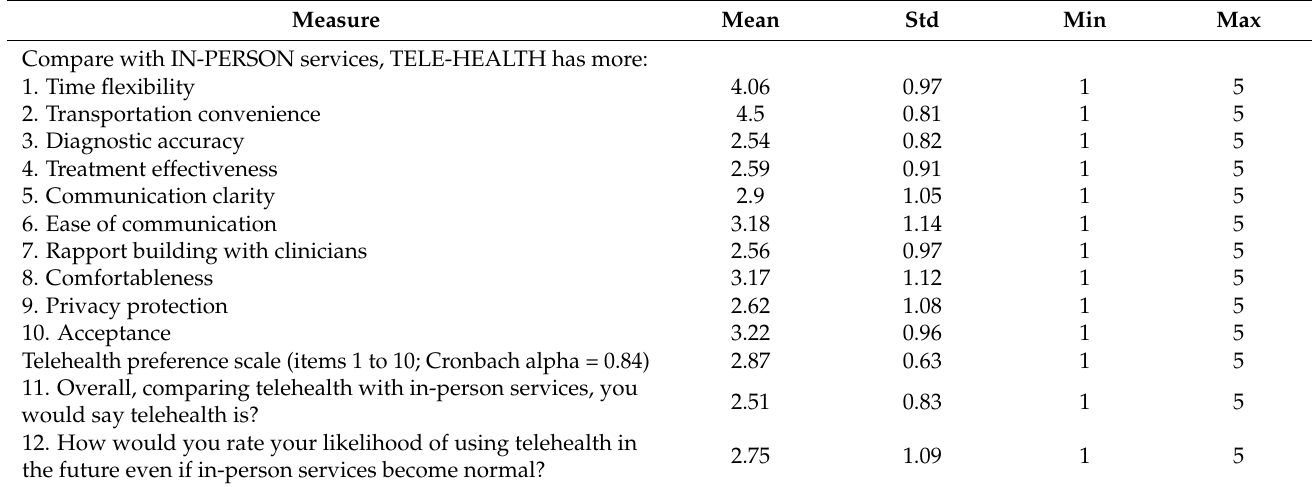
Table 2. Caregiver perceptions of telehealth versus in-person services ( n = 101). Measure Mean Std Min Max